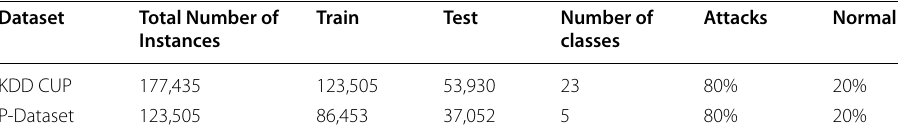
Table 2 Specifications of the proposed data set